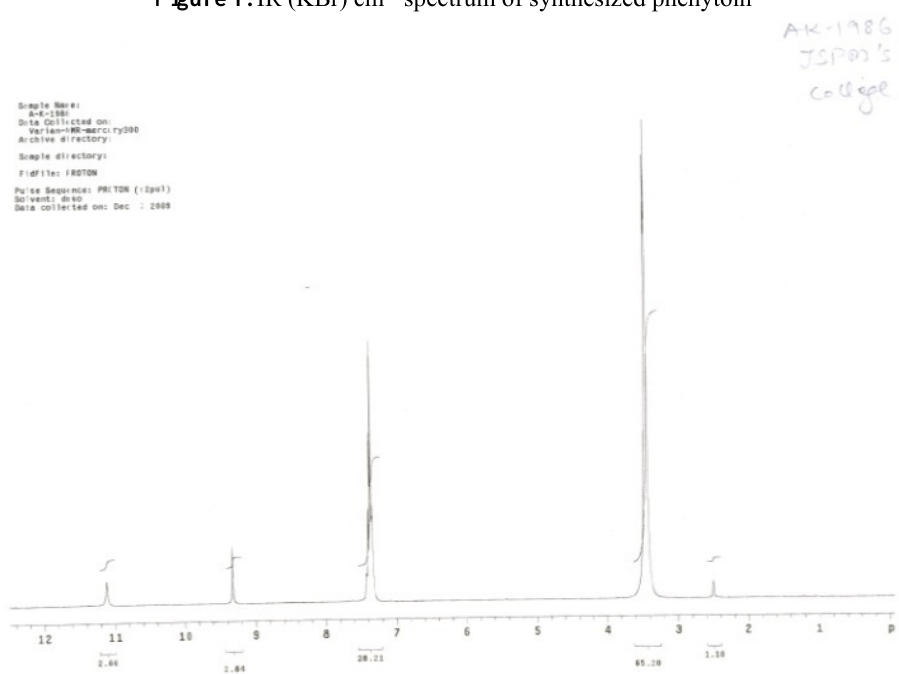
Figure 2 1 H NMR spectrum of synthesized phenytoin in DMSO